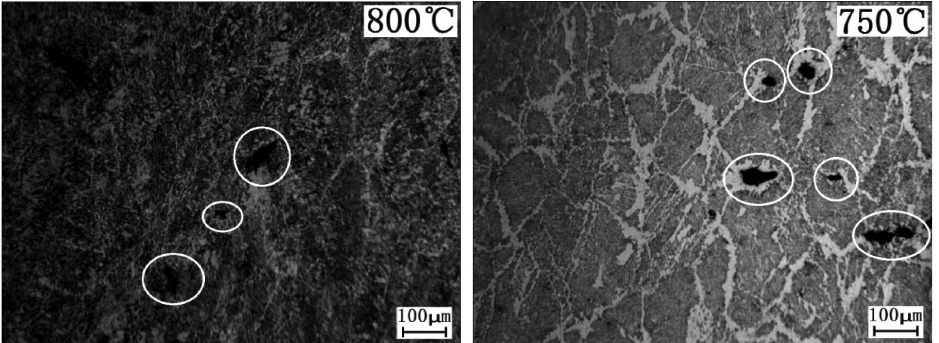
Fig. 12: Microstructure pictures at 800 °C and 750 °C in Ti-bearing